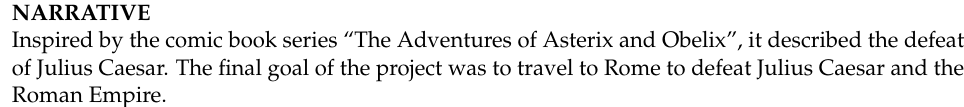
Table 1. Elements used in the gamification “Asterix conquers